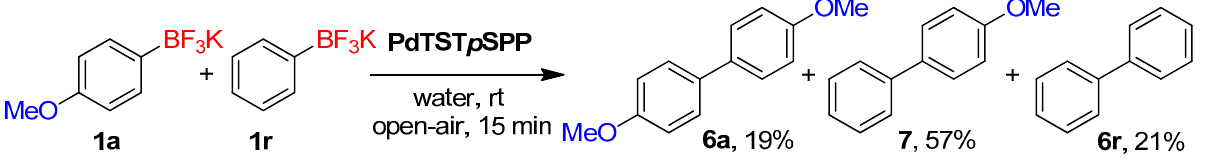
Scheme 2. Study of PdTST p SPP catalyzed hetero-coupling of PATFBs.